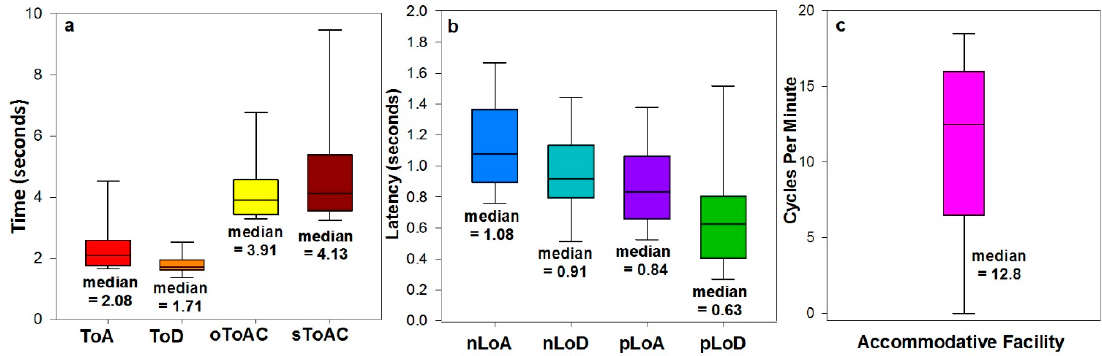
Figure 4. Box plots displaying the median, 10th, 25th, 75th and 90th percentiles of data for all accommodative metrics derived from the accommodative dynamic profile and accommodative facility.